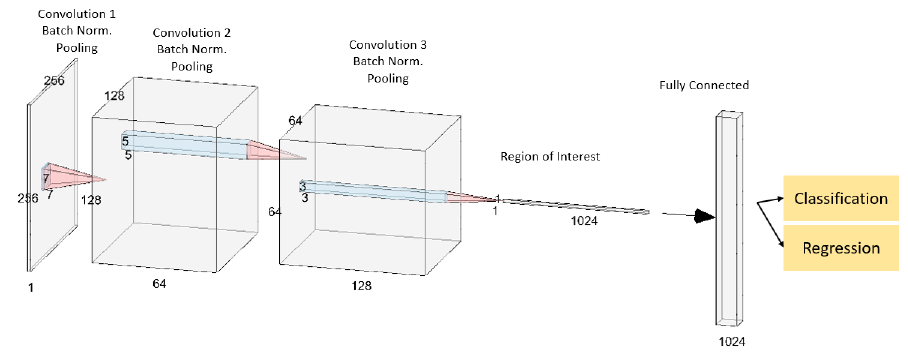
Figure 3. CNN architecture and its